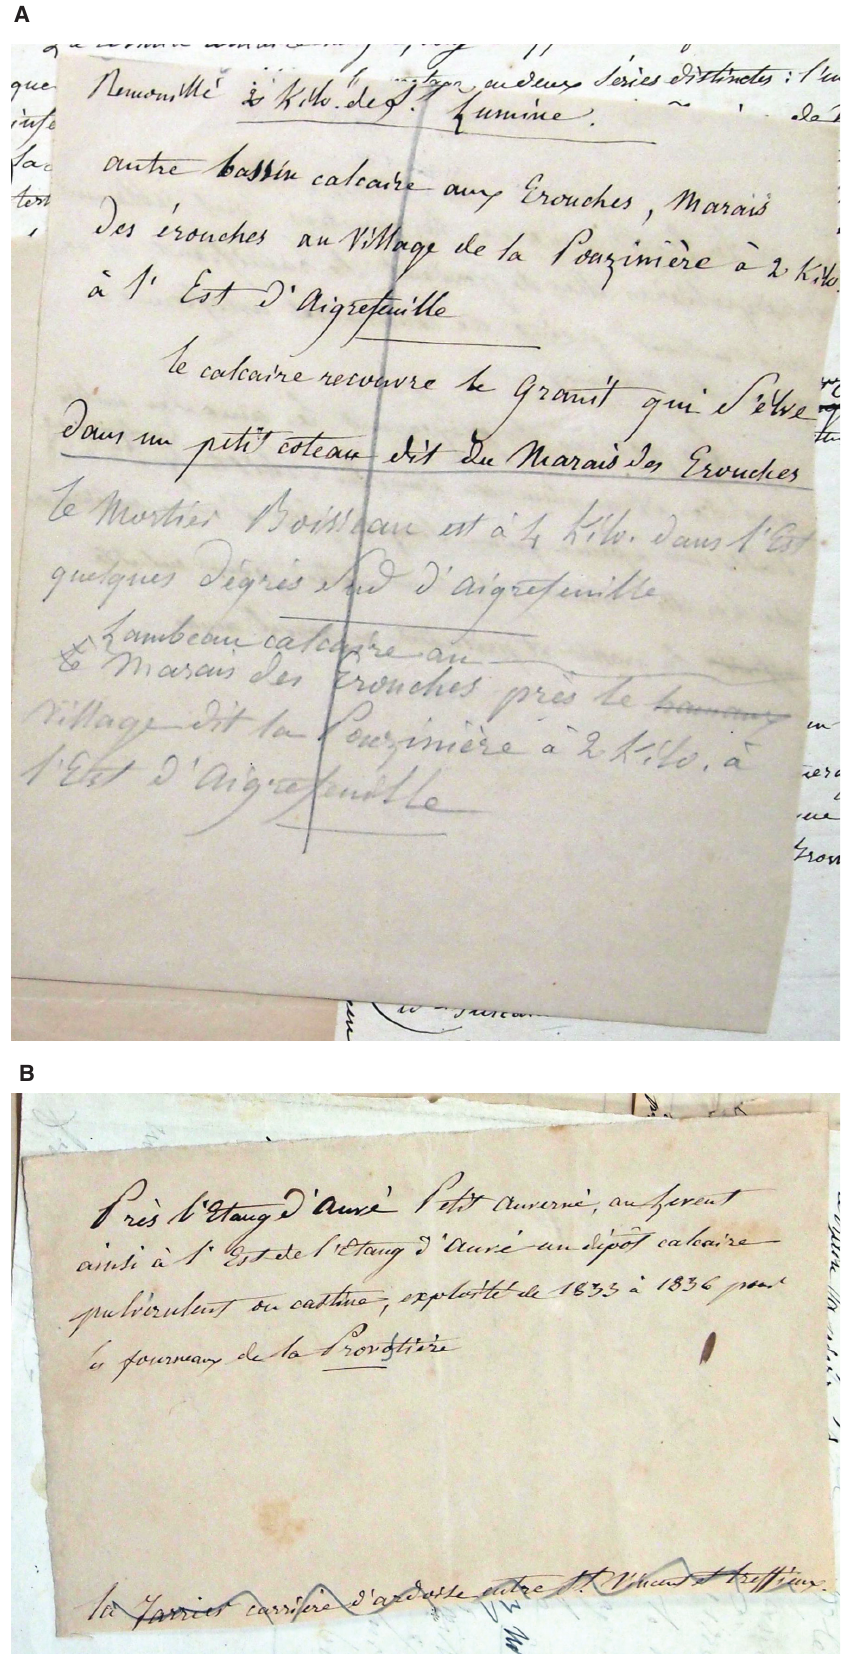
Figure 4: Examples of collected data on paper slips: Erouche marshes (A) and Auré pond (B). MHNN, 2R842, undated,